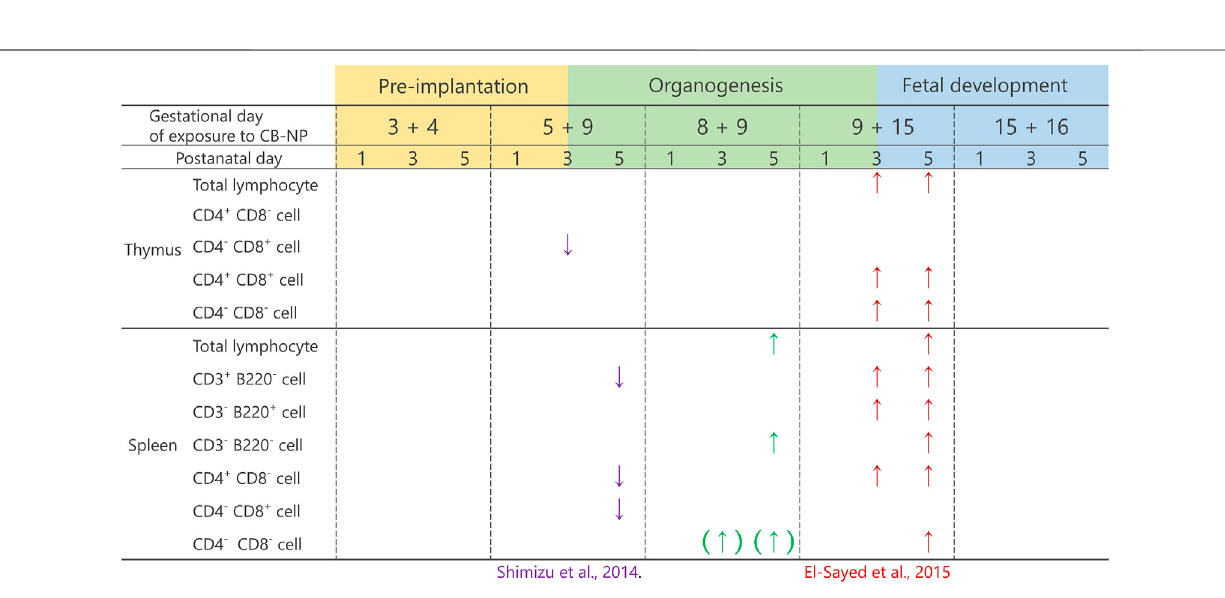
Frontiers in Toxicology |